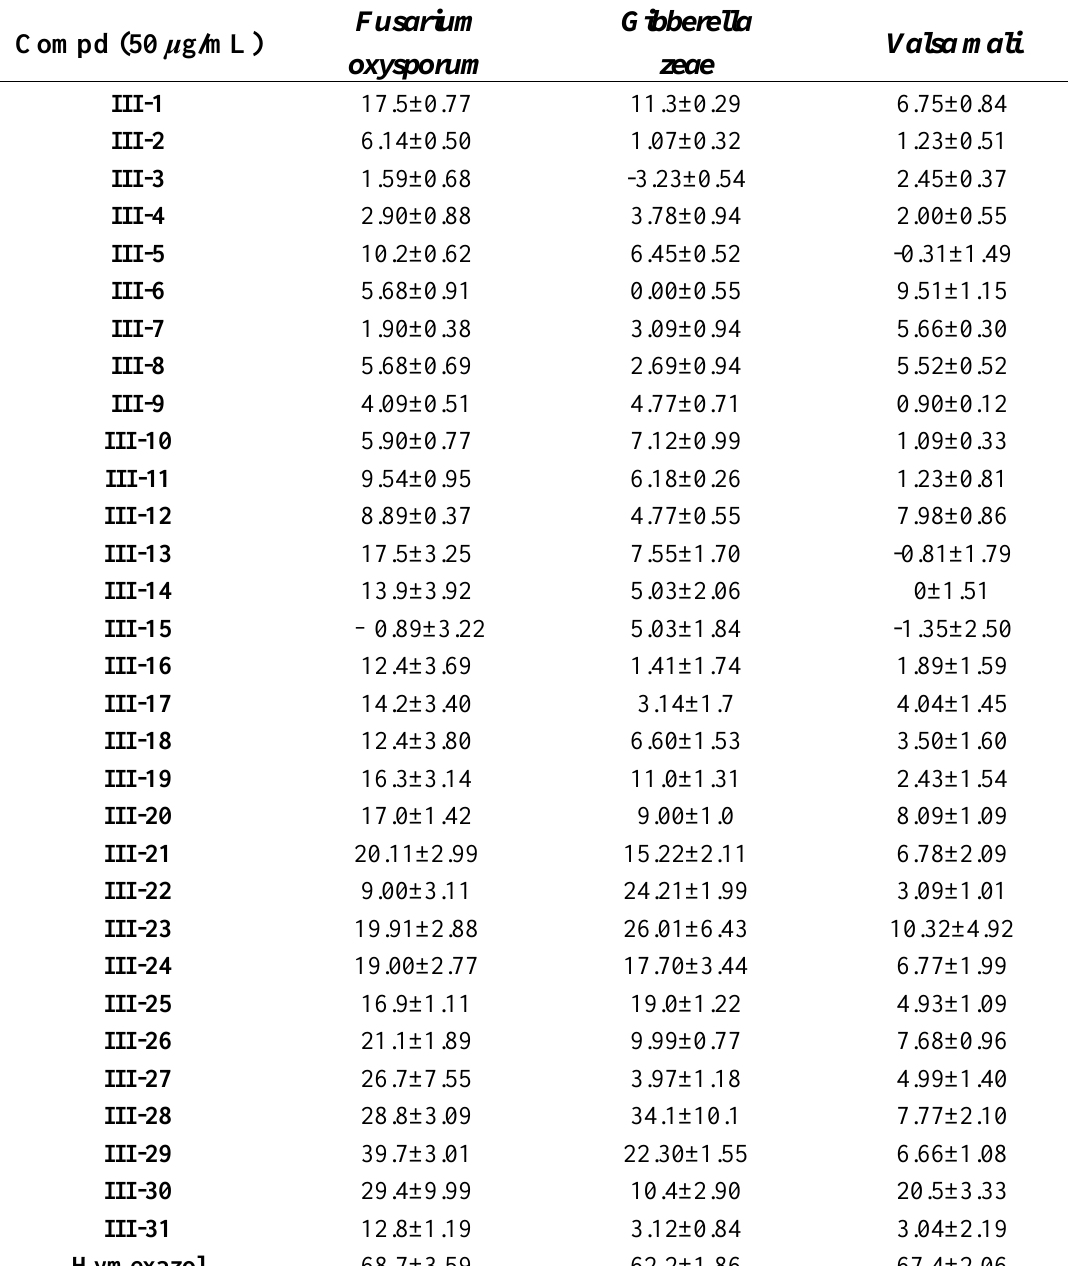
Table 5. Inhibitory effects on phytopathogenic fungi